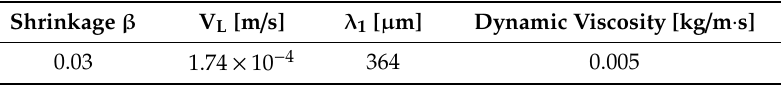
Table 6. Input values of parameters to solve Equation